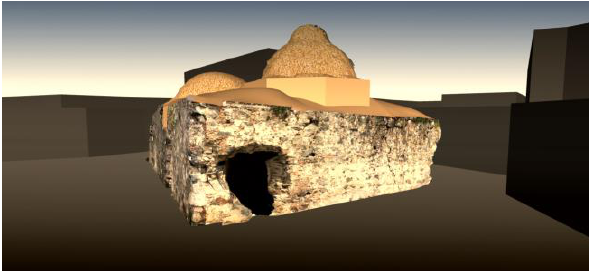
Figure 17. Above: Western Elevation; Below: Eastern elevation